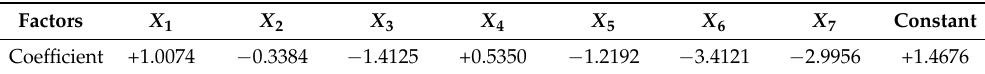
Figure 5. Cellular distribution of the samples. Table 1. The weight of influencing factors for the suitability of urban construction land.